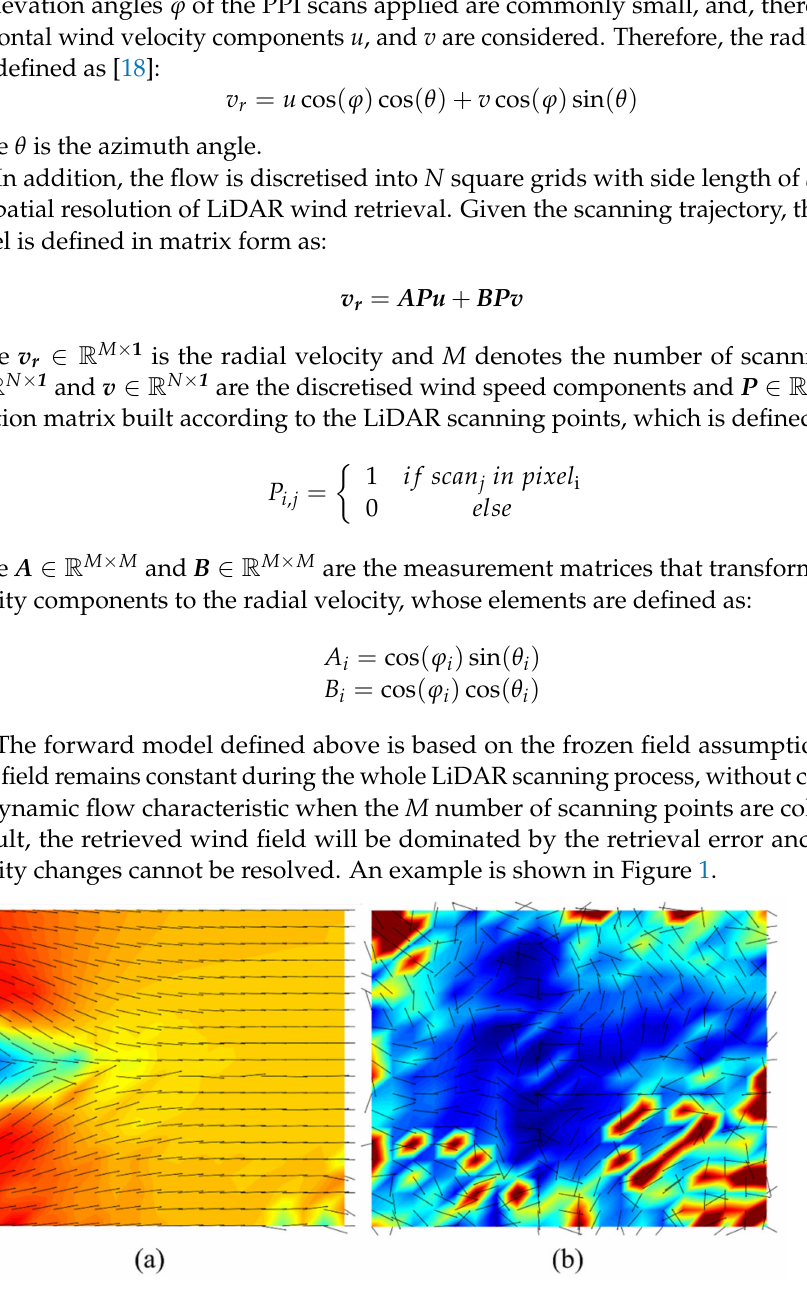
Figure 1. The original wind field ( a ) and the retrieved wind field ( b ) when the LiDAR system lacks the temporal resolution for fast changing wind